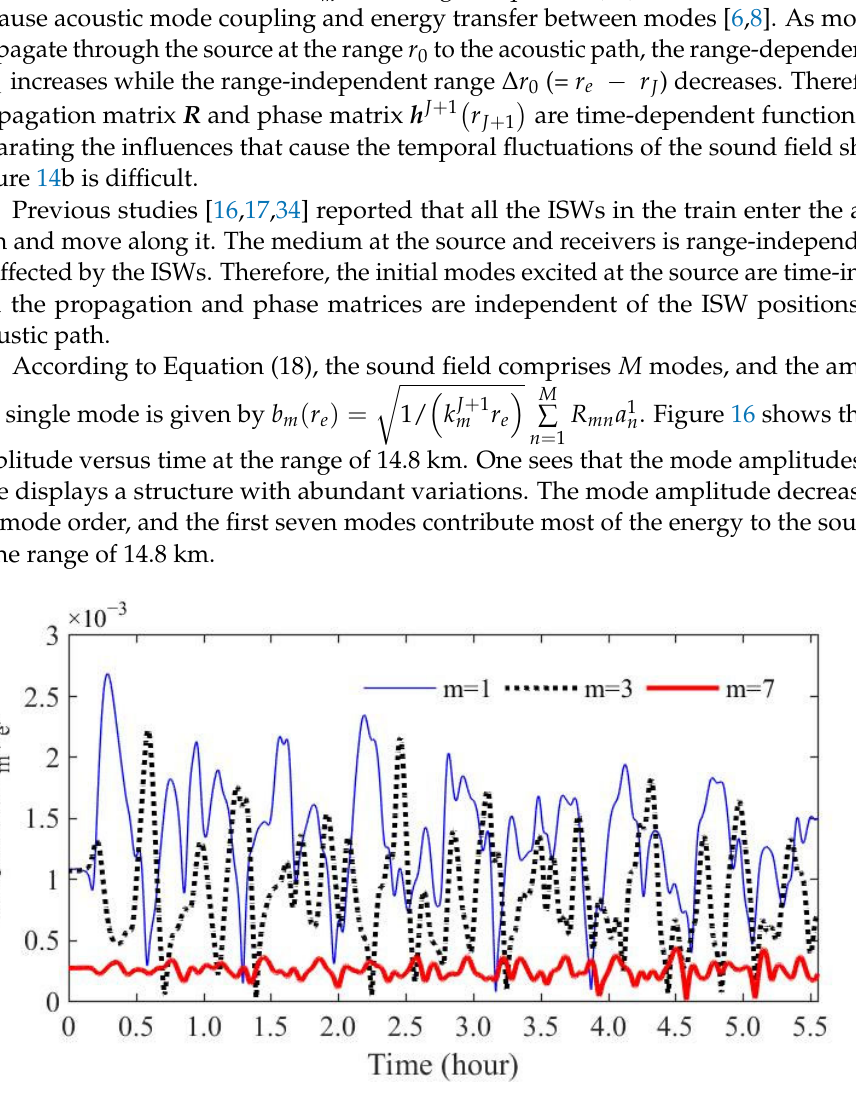
(cid:4666) 𝑟 (cid:4667) versus time for modes 1, 3, and 7. Figure 16. Mode amplitude 𝑏 Figure 16. Mode amplitude b m ( r e ) versus time for modes 1, 3, and 7. 𝑚 𝑒 Replacing the temporal correlation coefficient C ( t , t + τ ) in Equation (9) with the Replacing the temporal correlation coefficient 𝐶(cid:4666)𝑡 , 𝑡 (cid:3397) 𝜏(cid:4667) in Equation (9) with the mode amplitude b m ( r e ) obtains the spectrum Q ( b m ) , as shown in Figure 17. The fluctuation frequencies vary greatly with the mode number. Not all the mode fluctuations have (cid:4666)𝑟 (cid:4667) obtains the spectrum 𝑄(cid:4666)𝑏 (cid:4667) , as shown in Figure 17. The fluctu ‐ mode amplitude 𝑏 (cid:3040) (cid:3032) (cid:3040) significant predominant frequencies, which indicate that the sound field fluctuations result from some specific modes. A comparison between the spectra of the sound pressure